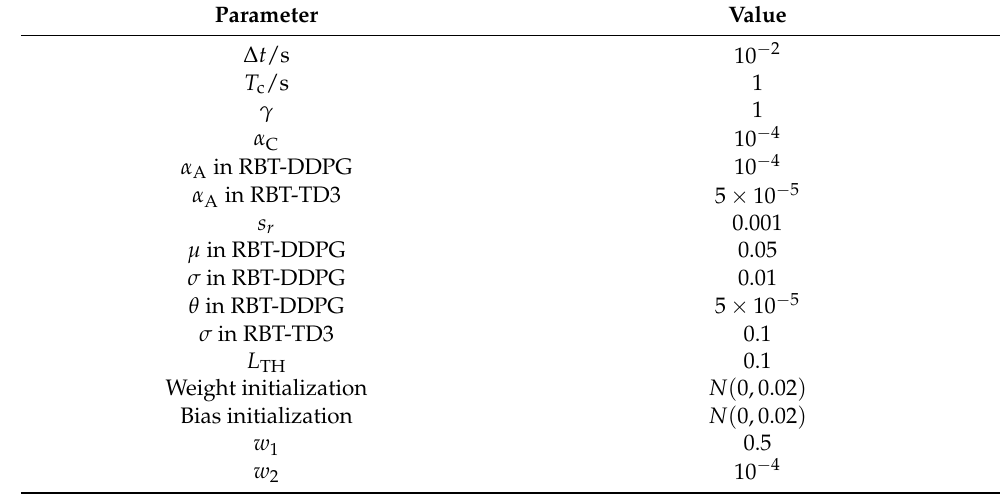
Table 2. Hyperparameters of RBT-DDPG and RBT-TD3.